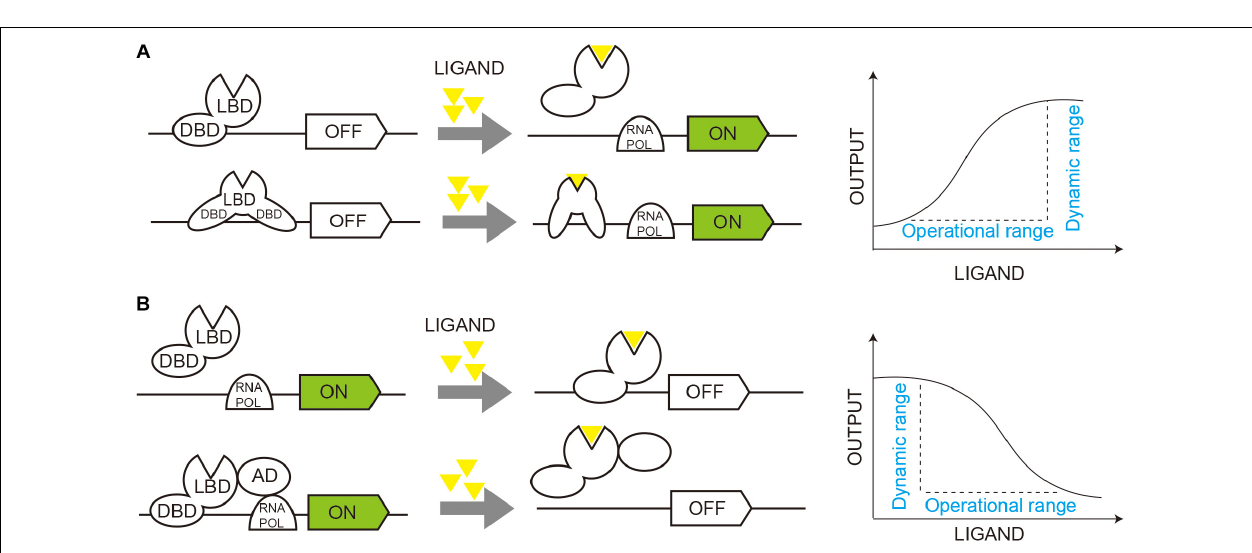
FIGURE 2 | Dynamic regulation of gene circuits through TF-based biosensors. (A) Activated regulation of gene circuits. Transcription factor (TF) functions as a repressor to inhibit gene transcription (OFF), and ligand binding induces a conformational shift in TF and activates gene transcription (ON). (B) Repressive regulation of gene circuits. TF functions as an activator of gene transcription (ON), and ligand binding induces a conformational shift in TF and inhibit gene transcription (OFF). DBD, DNA binding domain; LBD, ligand binding domain; RNA Pol, RNA